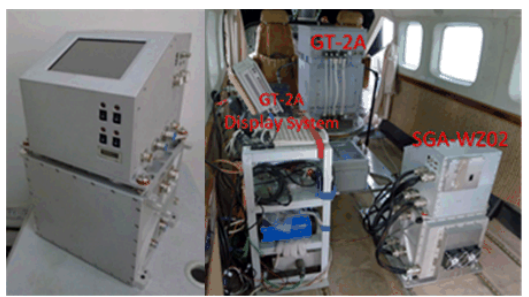
Figure 10. Appearance of SGA-WZ02 and the picture of the flight cabin.